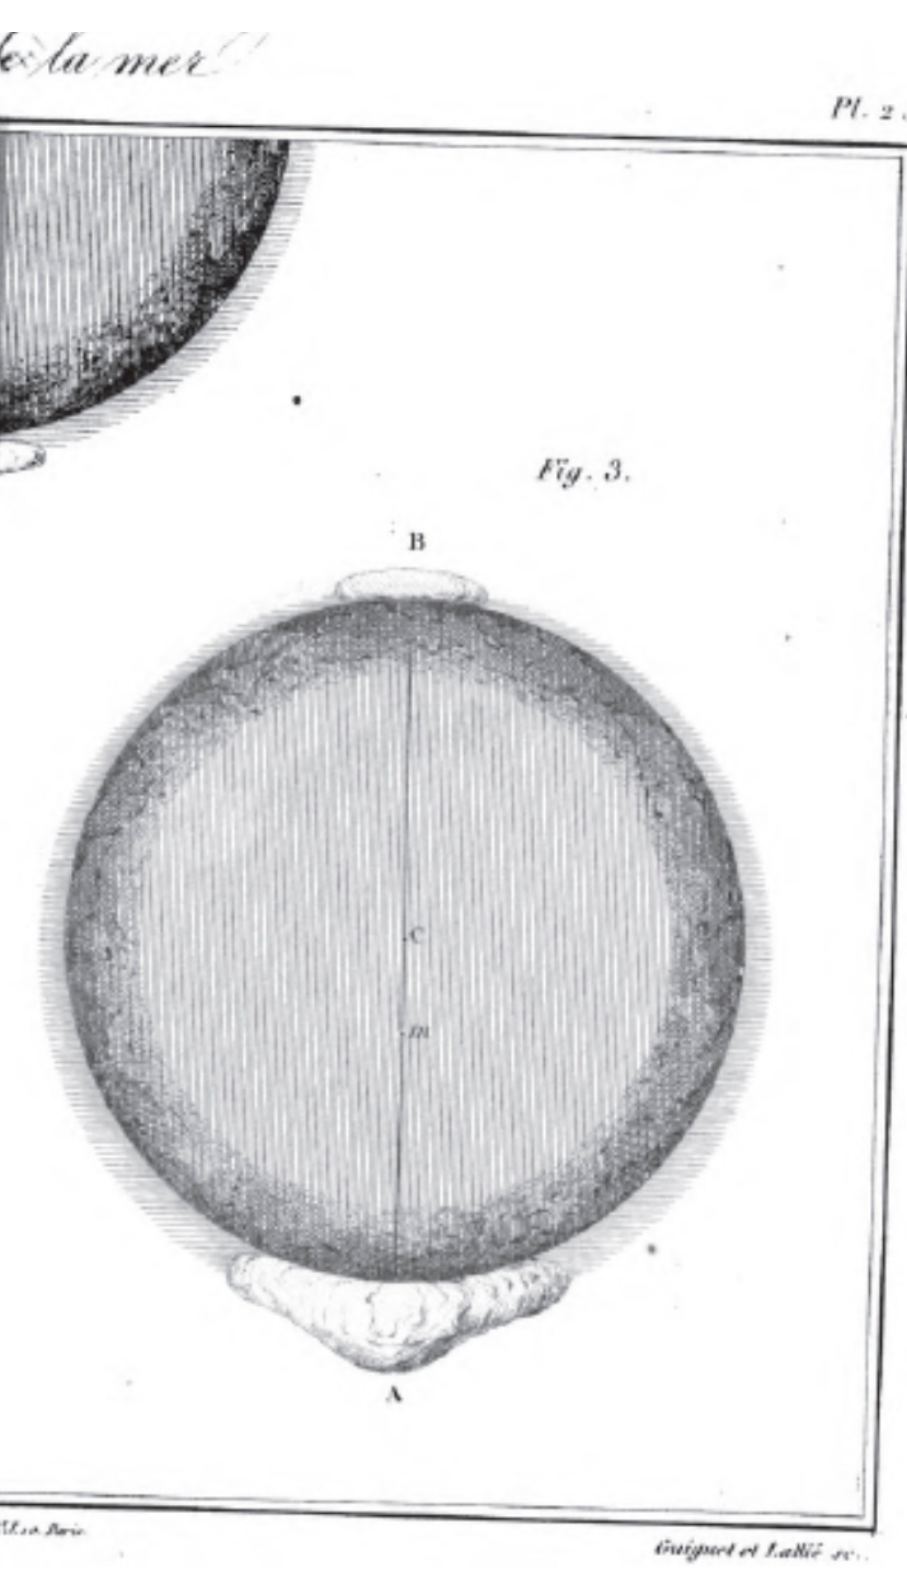
Figure 6. Adh é mar’s drawing of the polar ice capin Figure 6. Adhémar’s drawing of the polar ice capin Antarctica.